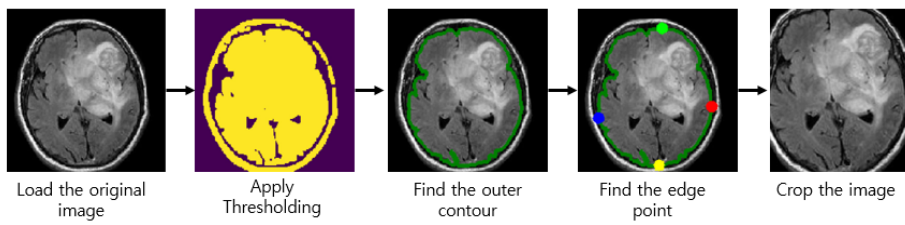
Figure 2. Step to crop the magnetic resonance (MR) images.